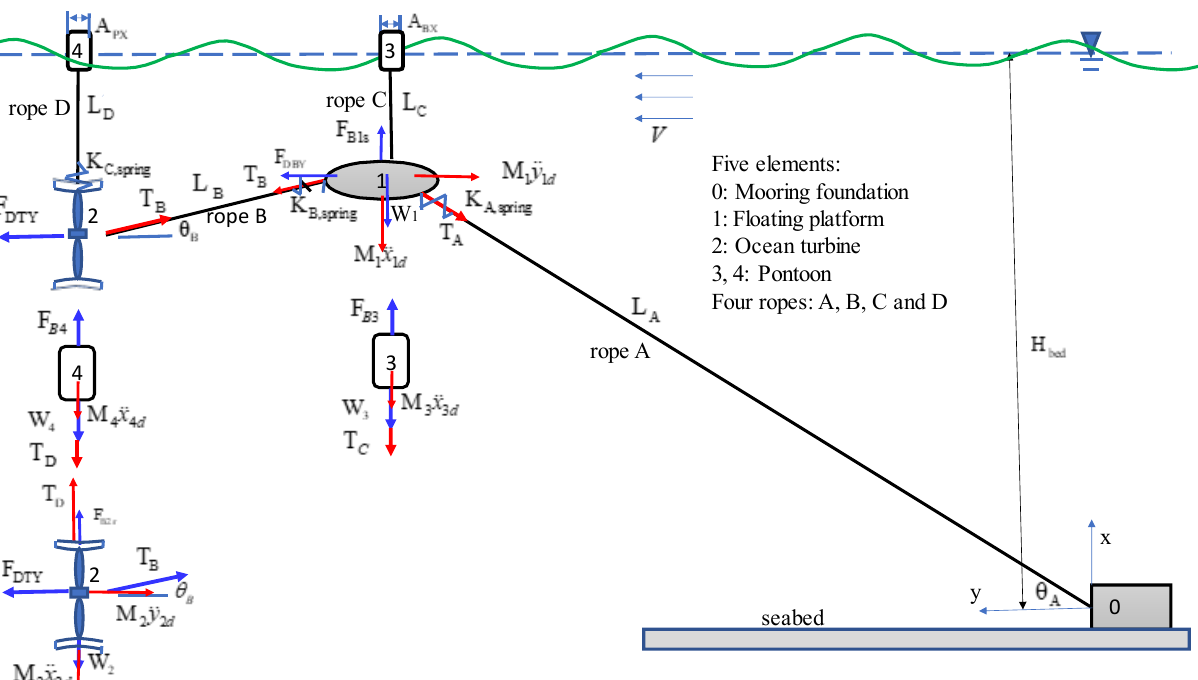
Figure 2. Coordinates of the current energy system composed of submarined ocean turbine, pontoon, floating platform, traction rope and mooring foundation in the dynamic state under steady ocean current and wave.